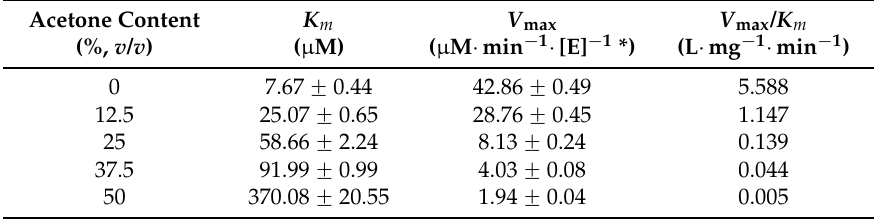
Table 1. Michaelis-Menten constants of laccase in aqueous media of different acetone